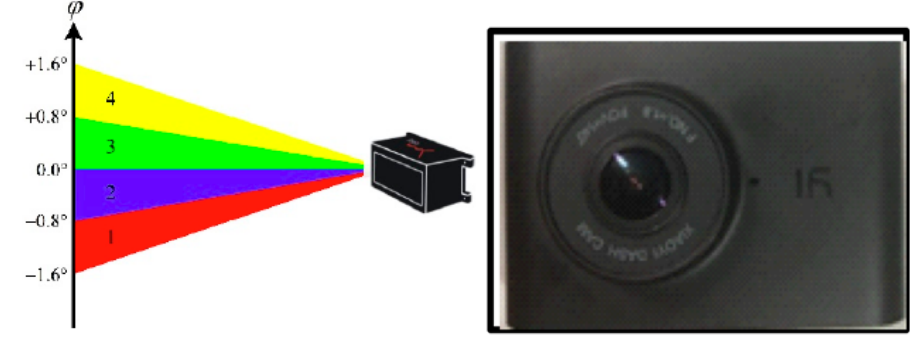
Figure 4. Parameter acquisition equipment.